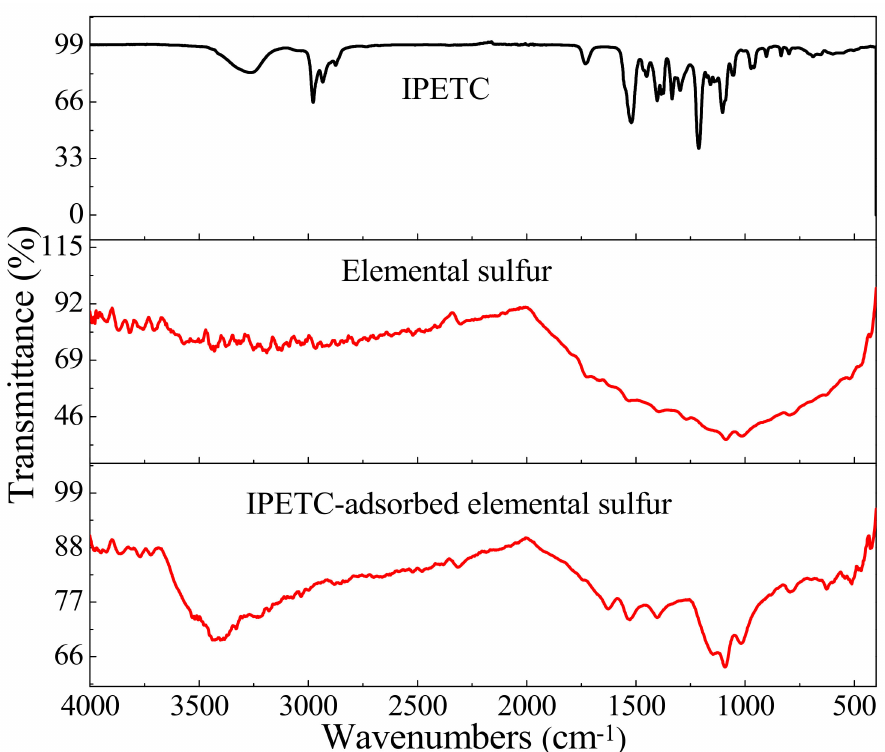
Figure 12. FTIR spectra of IPETC, elemental sulfur and IPETC-adsorbed elemental